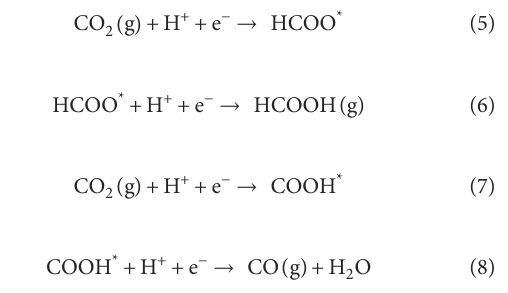
FIGURE 5 The computed difference in enthalpy between the C 2 mm and P 62 m phases of U 3 O 8 . The predicted phase transition is at the content of Am of 1.2%.